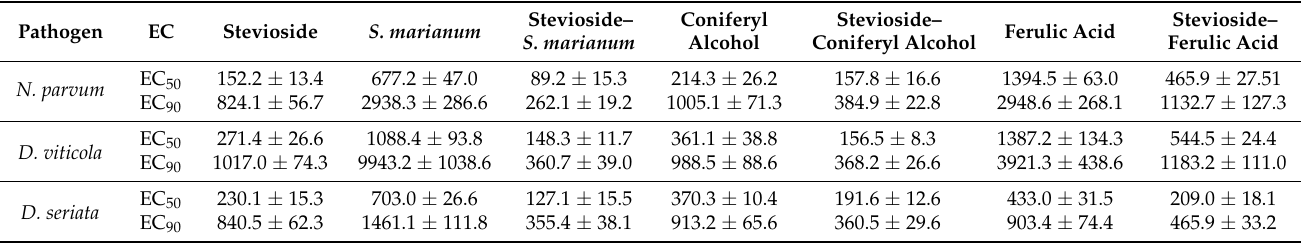
Table 4. Estimated EC 50 and EC 90 effective concentrations. Values are expressed in µ g · mL − 1 , and are followed by the standard errors of the fit.